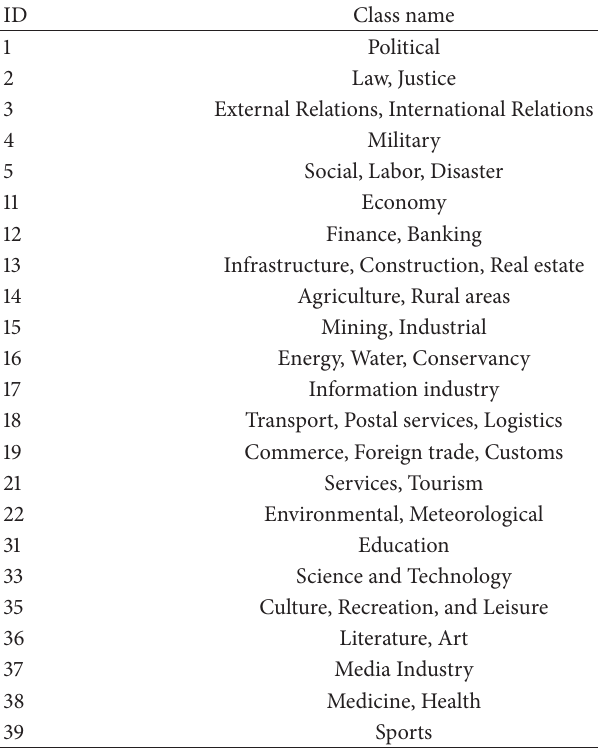
Table 1: Name of each